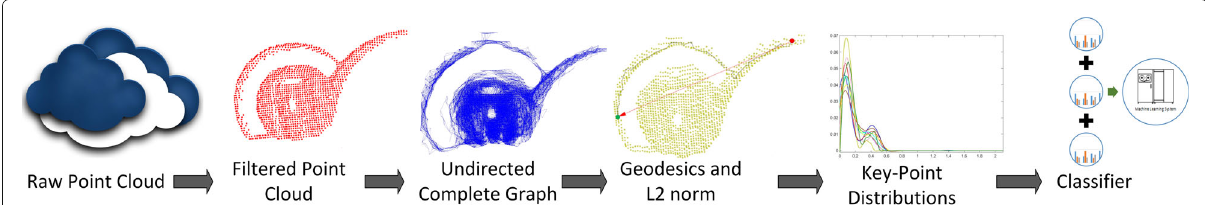
Fig. 4 Pipeline of the approach depicting different steps in it. The raw point cloud is filtered to make it noise-free. The filtered point cloud is then converted into a graphical representation, where every node is connected with every other node within certain sphere around it. Geodesics and L2 norms are calculated using Dijkstra algorithm. A distribution is made for each view of the object based on these distances and normalized to a PDF. In the last stage, these PDFs are fed into a classifier to build a hypothesis